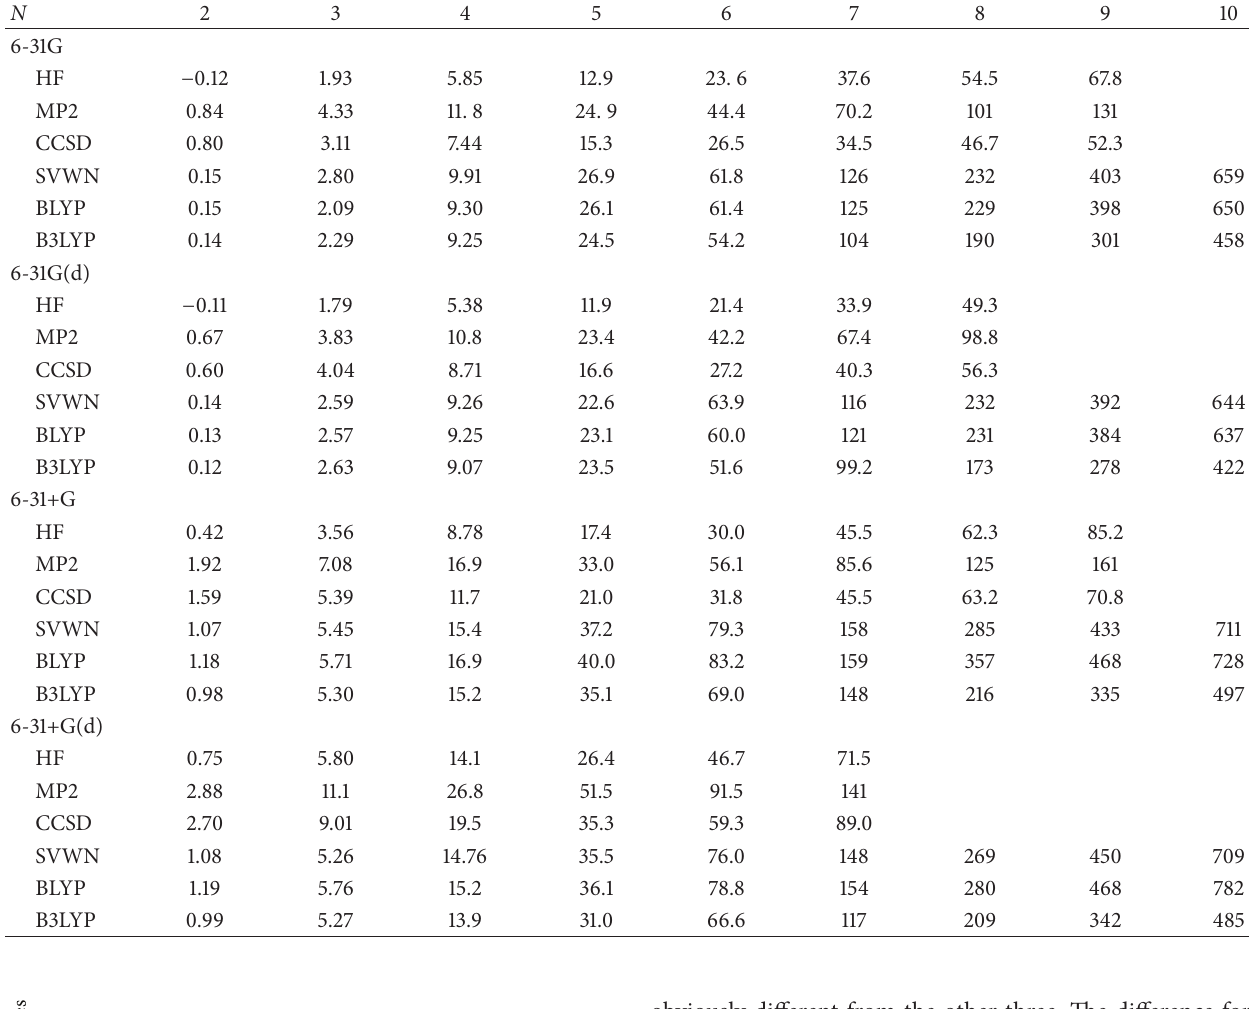
obviously different from the other three. The difference for /𝑁 between 6-31+G(d) basis set and other basis sets ranges 𝛾 𝐿 from 41% to 61%. And the 6-31G, 6-31+G, and 6-31G(d) basis sets perform